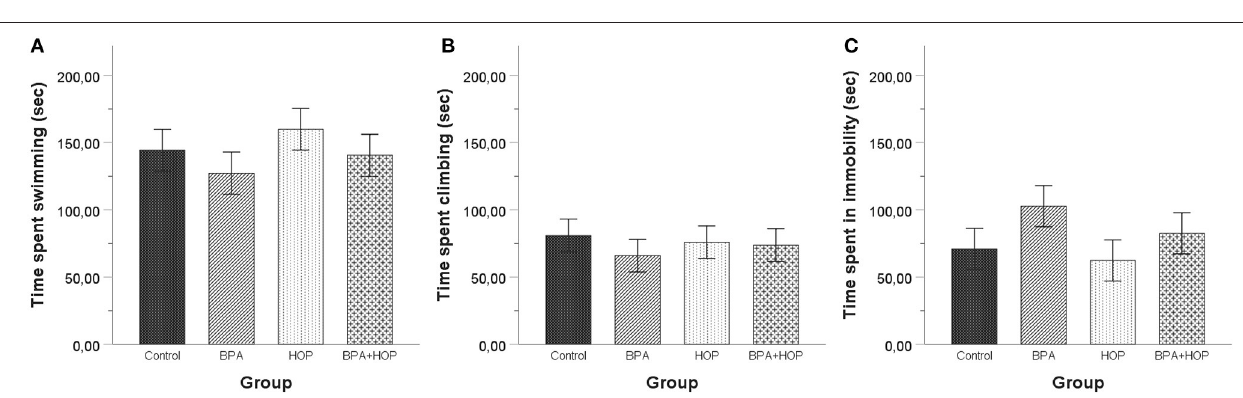
FIGURE 6 | All rats were tested in the forced swim test on PND 60 (habituation) and PND 61 (5-min swim test). No differences were observed between the rats in time spent swimming (A) , climbing (B) , or being immobile (C) . A trend toward spending less time swimming and climbing and more time motionless was apparent in BPA-treated compared to control and Hop-treated rats. Data are represented as mean ±